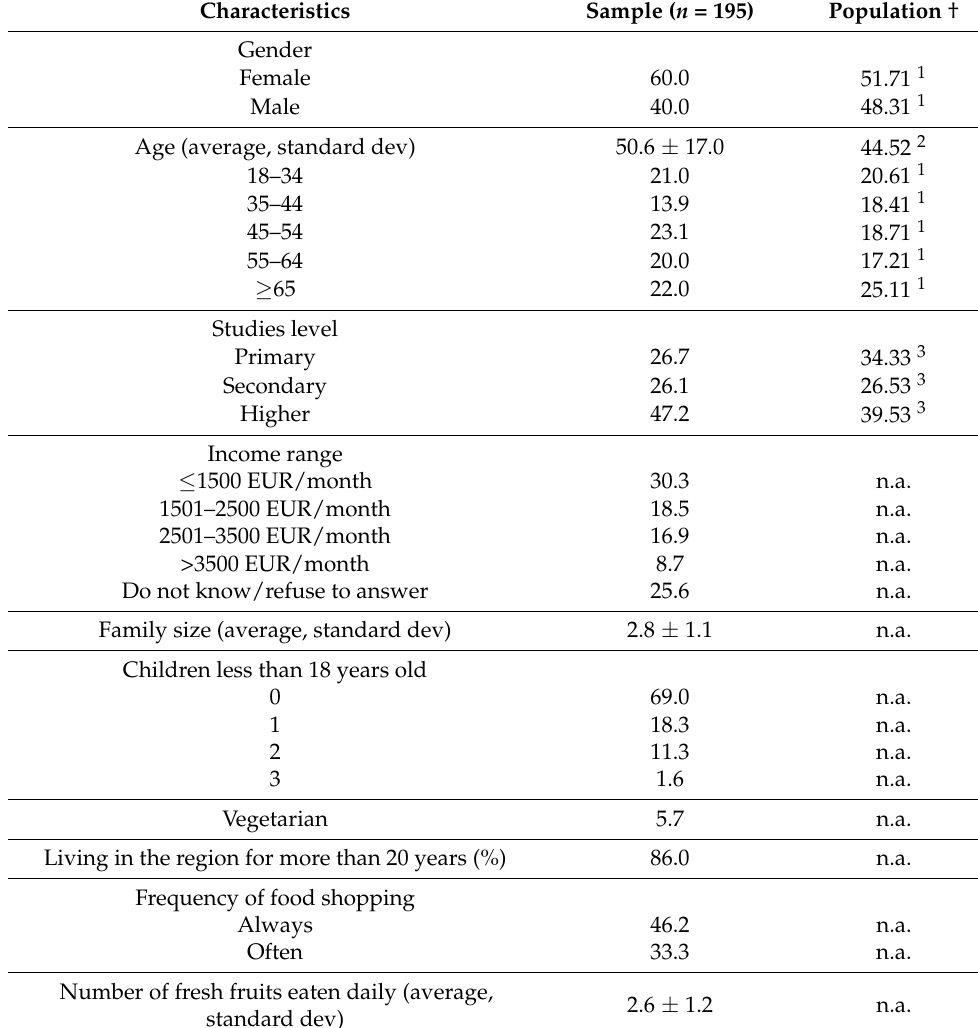
Table 1. Socio-demographic characteristics of apple consumers population